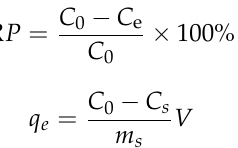
Initial concentration of pollutant (mmol/L) 25? 40? 55? Figure 3. Relationship between initial concentration and adsorption concentration. 3.1.2. Adsorption Model of Zn by Mixed Soil The Langmuir model, Freundlich model and Dubinin - Radushkevich (D-R) model were used to fit the isothermal adsorption data, respectively, in order to investigate the maximum adsorption amount of Zn and the adsorption mechanism of the mixed soil. The Equations of the three models are shown in (4–8).